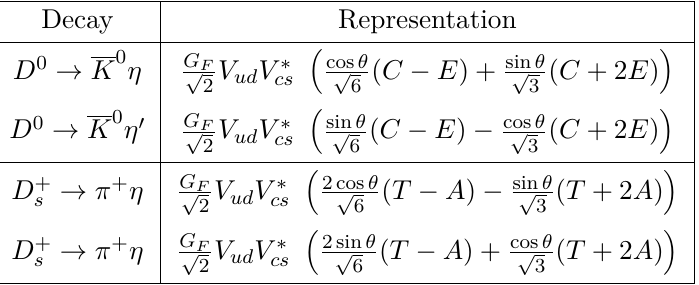
Table 4. Amplitudes for η − η 0 CF decays in the topological-diagram representation with the assumption that the octet and singlet diagrams are